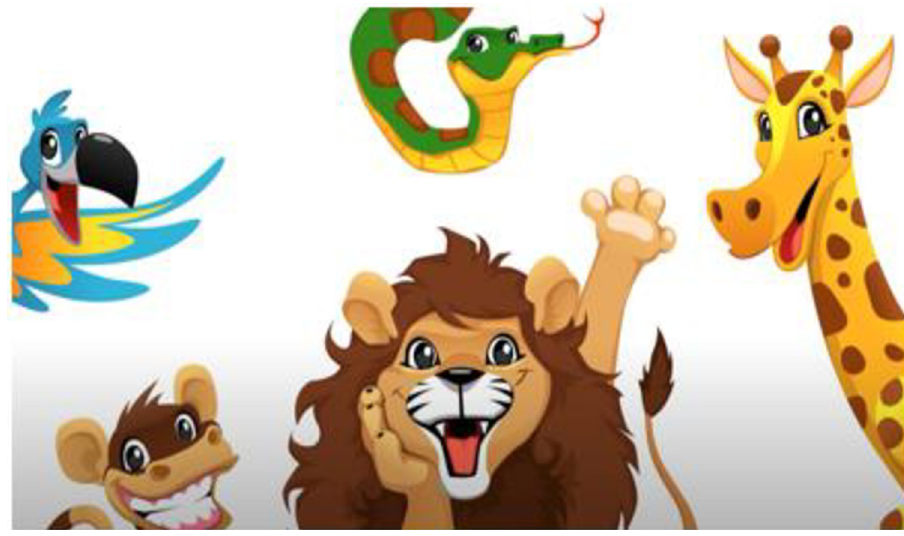
Fig 7. The animal animation as a